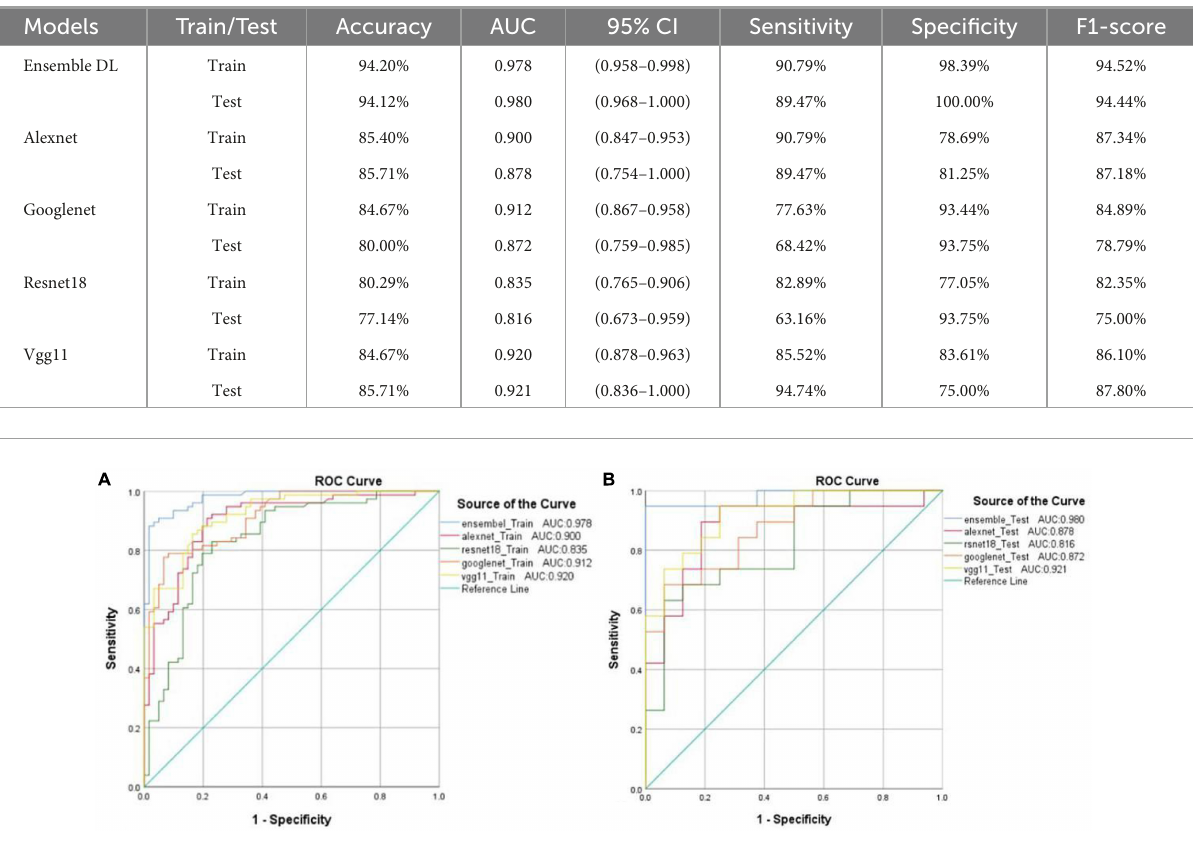
FIGURE4 Receiver operating characteristic (ROC) curves and the area under the receiver operating characteristic (AUC) values from five different models in the training set (A) and testing set (B) .